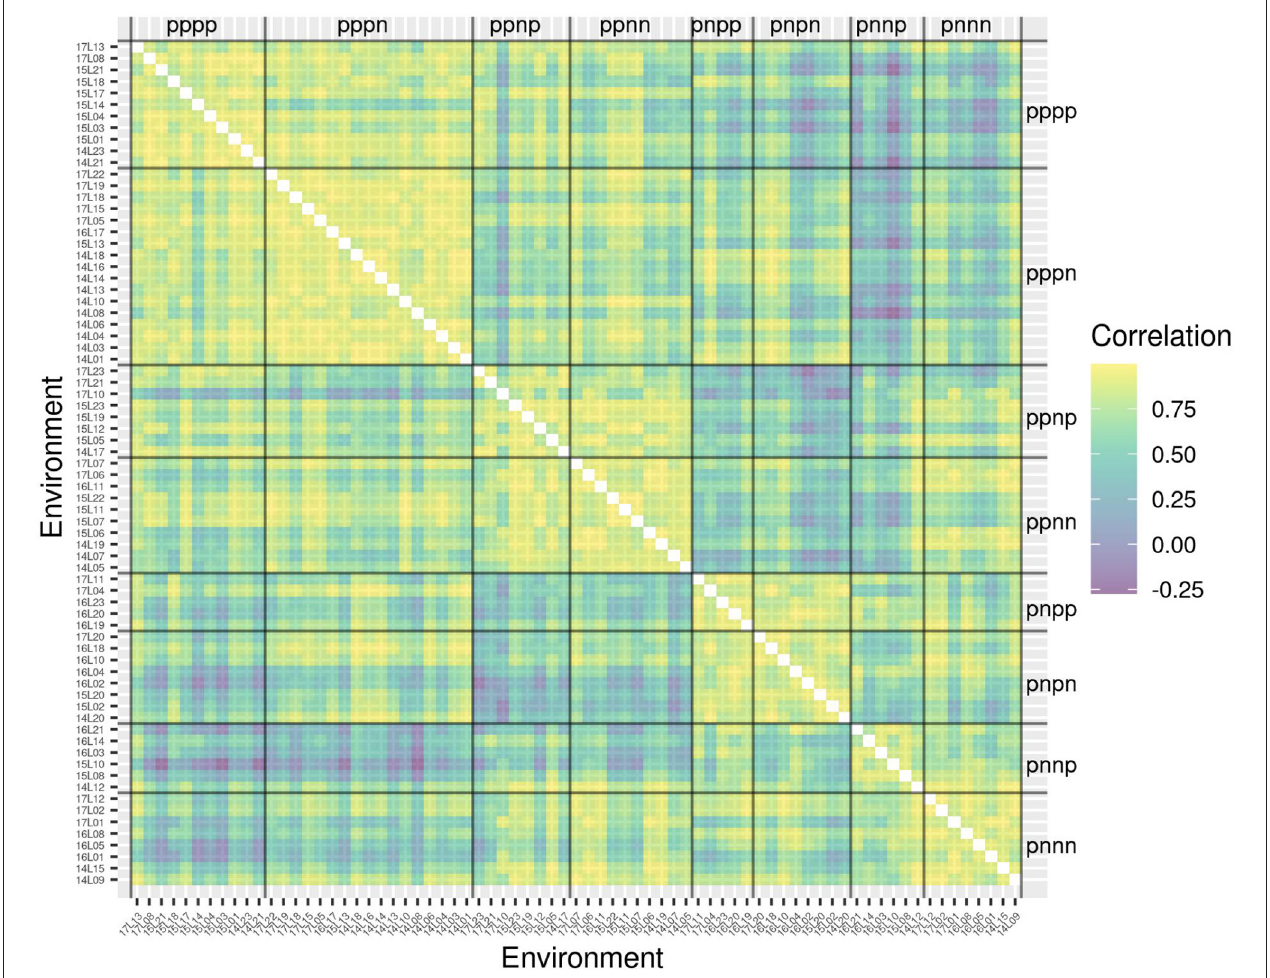
FIGURE 1 | Estimated genetic correlations for CVE effects for all pairs of environments. Environments are ordered according to